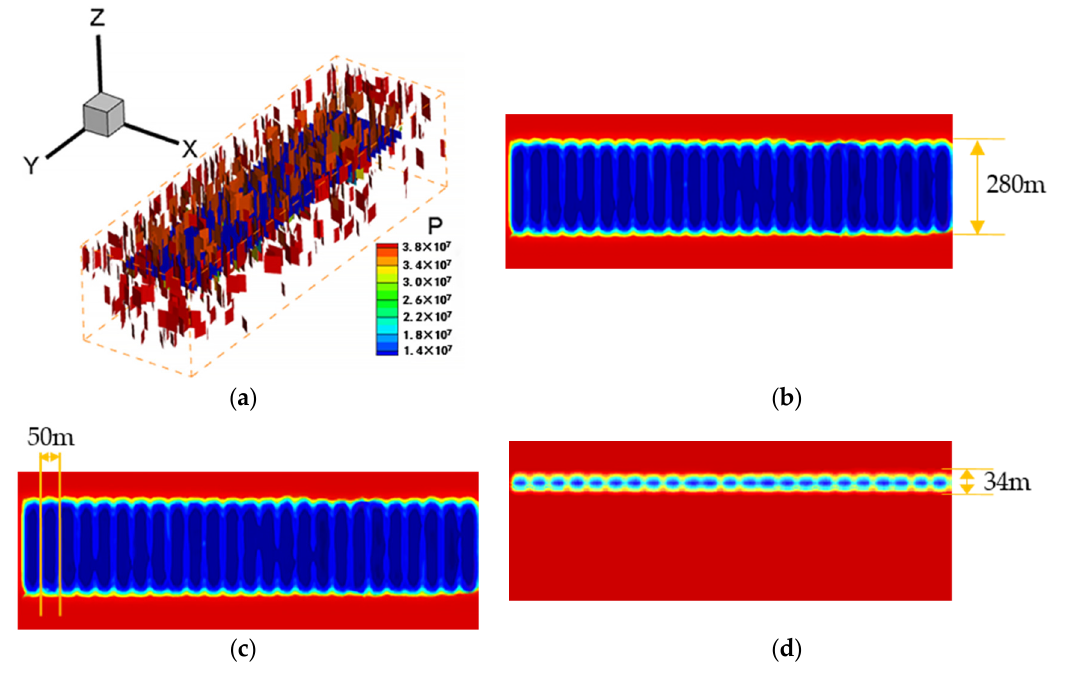
Figure 5. Pressure changes and reservoir utilization range after 15 years of high-density (0.012 m/m 2 ) natural fracture reservoir exploitation: ( a ) Pressure field diagram; ( b ) Utilization range in X direction; ( c ) Utilization range in Y direction; ( d ) Utilization range in Z direction.